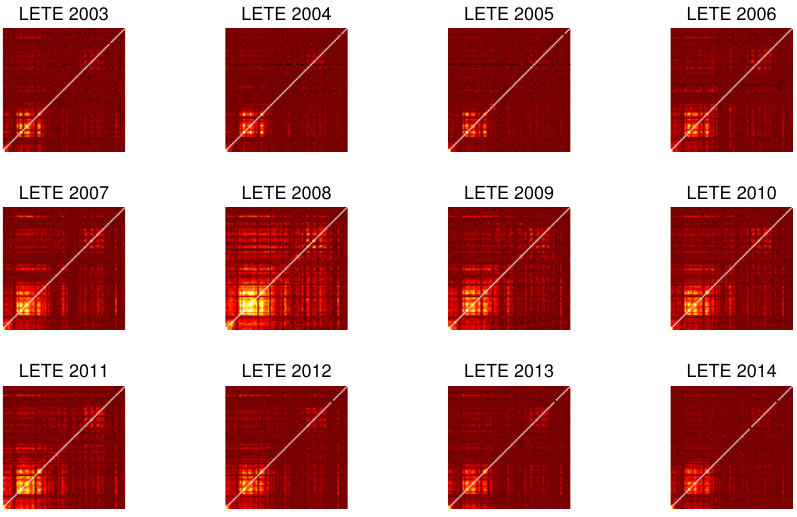
Figure 9. Correlation matrices for each of the years of data for Sector 1 (original × original variables). Brighter colors denote higher correlation, and darker colors denote lower correlations.